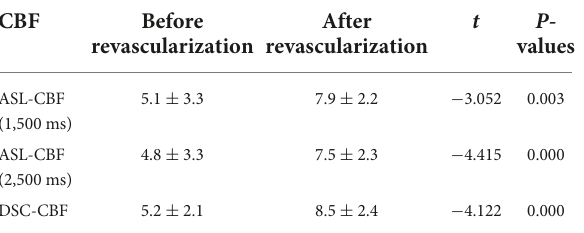
TABLE 4 Comparison Alberta Stroke Program Early CT Score (ASPECTS) area ischemia scores before and after revascularization. CBF Before After revascularization revascularization